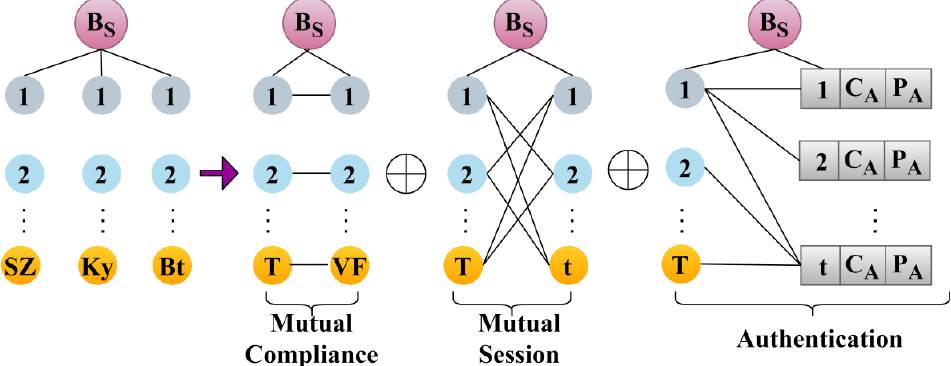
Figure 3. Classification through mutual service.